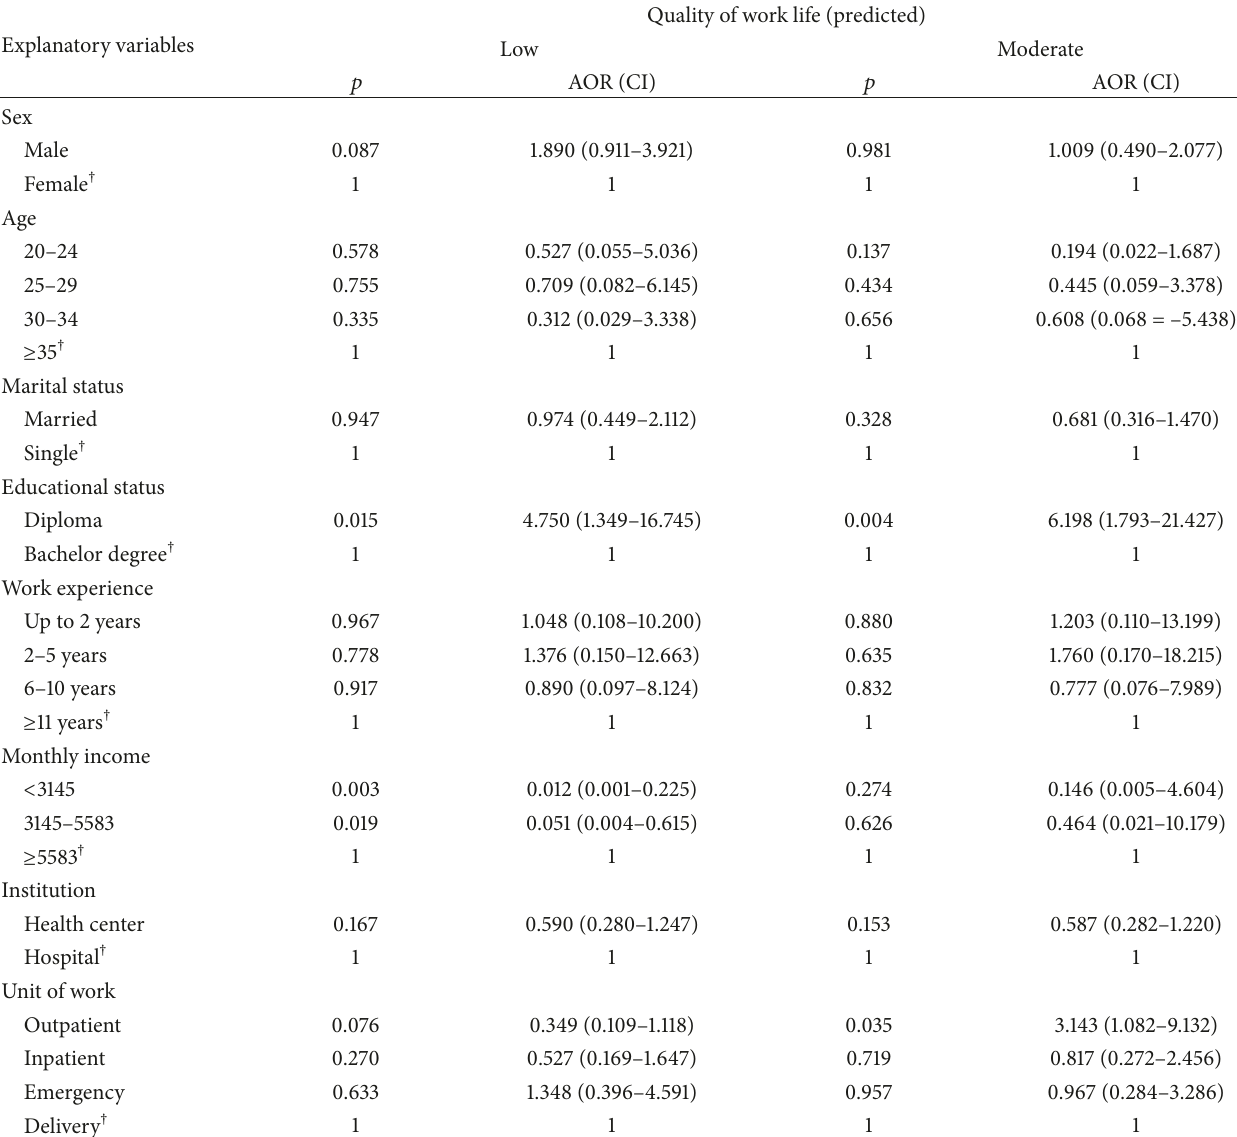
Table 3: Background characteristics as predictors of quality of work life among nurses working in public health facilities of Hawassa town, March 10–27, 2016 ( 𝑛 = 253 ).